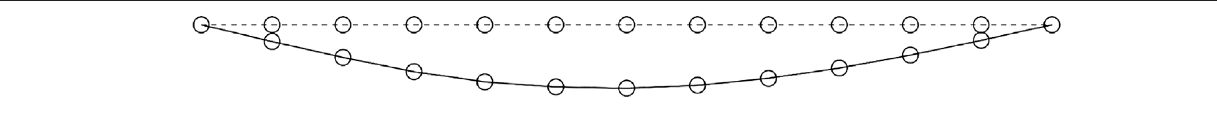
FIGURE 3 | Deformation diagram of simply supported beam.